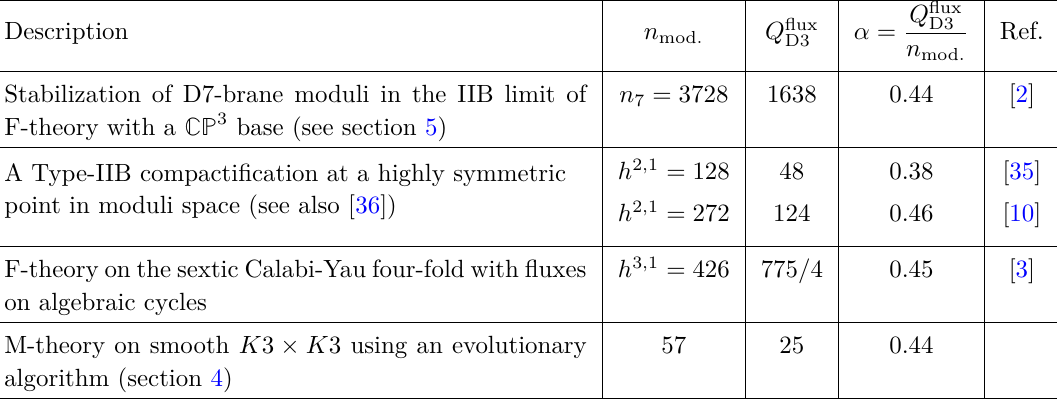
Table 1. Examples for flux compactifications at a large number of moduli. We give the number of moduli which are stabilized by fluxes, n , the charge induced by the fluxes which stabilize these mod . moduli, Q flux ,and the corresponding value of α in the tadpole D3